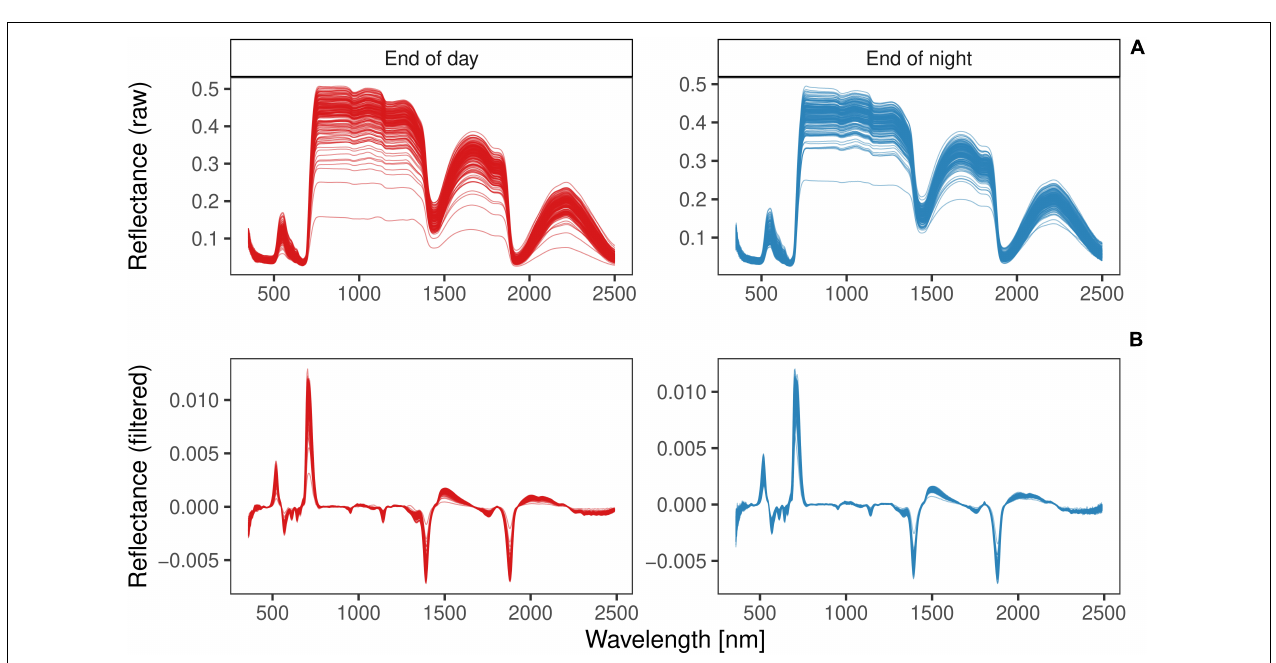
FIGURE 6 | Raw (A) and Savitzky-Golay pre-processed reflectance spectra (B) of red clover samples of the training set ( n = 338) harvested at the end of day (ED; red) or end of night (EN; blue).